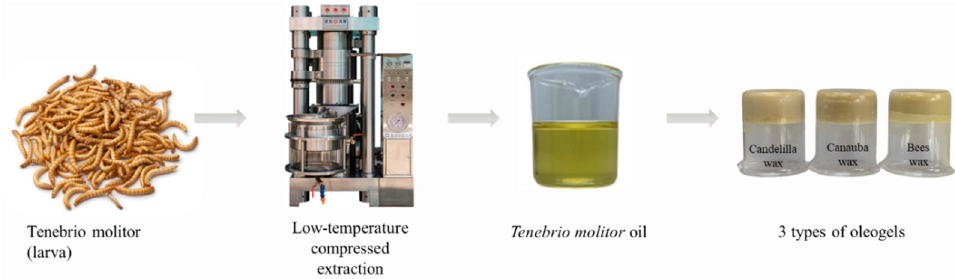
Figure 6. Extraction of Tenebrio molitor oil and preparation of oleogels with different oleogelators.